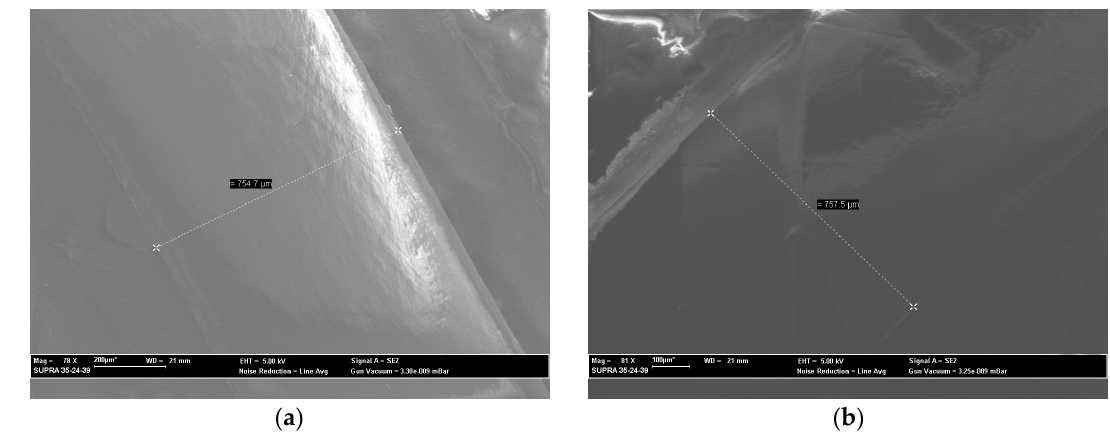
Figure 3. SEM images of the D-shaped sensors: ( a ) Sensor 2; ( b ) Sensor 5.